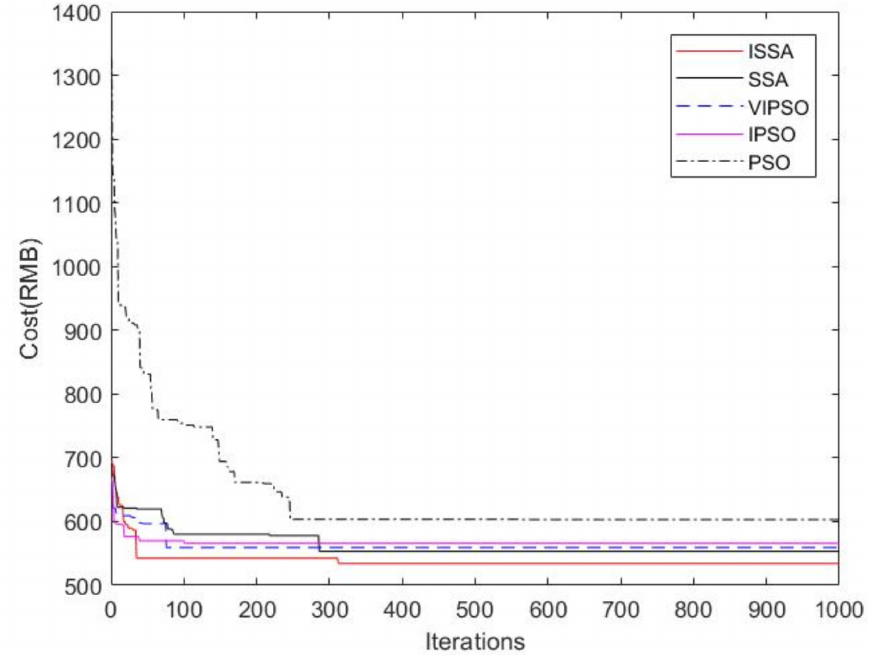
Figure 11. The fitness evolution curve of single-objective